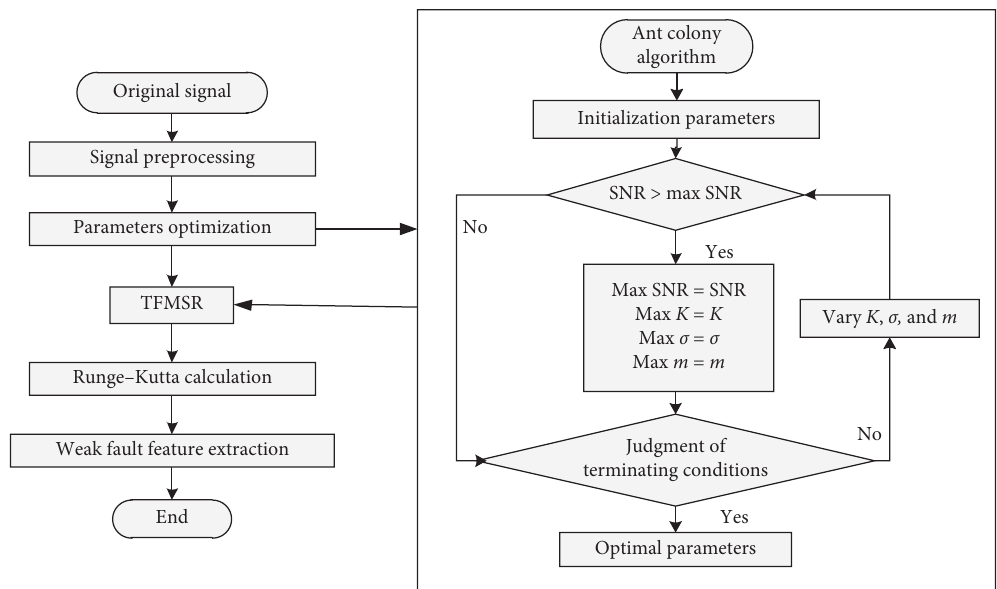
Figure 4: TFMSR weak signal detection strategy.